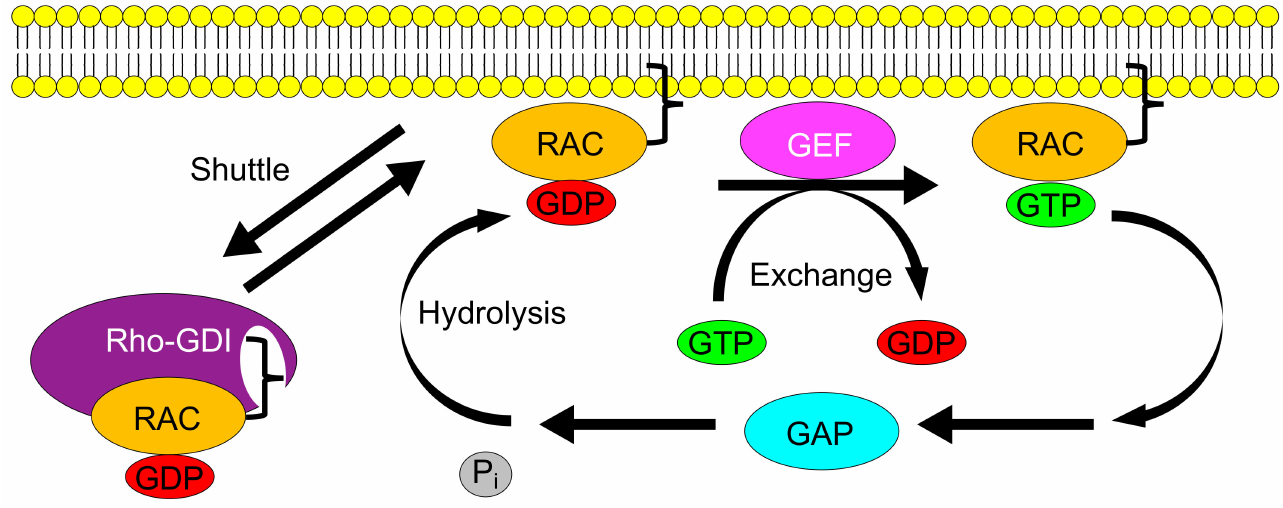
Figure 1. Illustration of the Rac activation cycle. Racs are active in their GTP-bound state and inactive when bound to GDP. The vast majority (90–95%) of Rac proteins are inactive and sequestered in the cytosol by Rho-GDI. Activation begins with the shuttling of Racs to the plasma membrane, where they can be activated by the GEF-mediated exchange of GTP for GDP. GAPs facilitate the hydrolysis of GTP to GDP and inorganic phosphate, leading to inactivation. Isoprenylation (black bracket) anchors Racs to the plasma membrane but also plays a role in Rho-GDI binding so that Rho-GDI can also shuttle inactive Racs away from the plasma